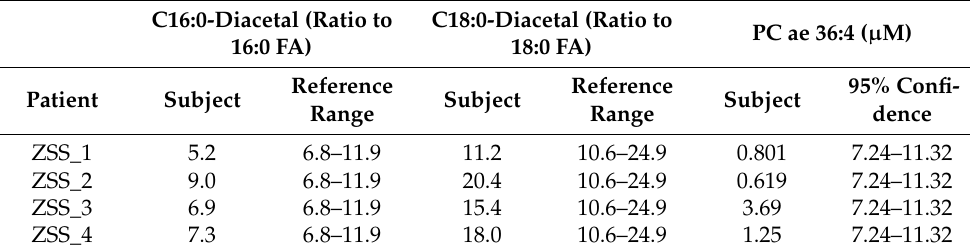
Table A2. ZSS patients with irregularly high GC-MS plasmalogen markers can still be identified as plasmalogen deficient by the FIA-MS marker PC ae 36:4. Red blood cell membrane plasmalogen from PEX1 patients was analyzed using GC-MS and serum from the same sample was analyzed using the Biocrates AbsoluteIDQ p180 kit. For reference range 95% confidence interval from 28 controls were used.